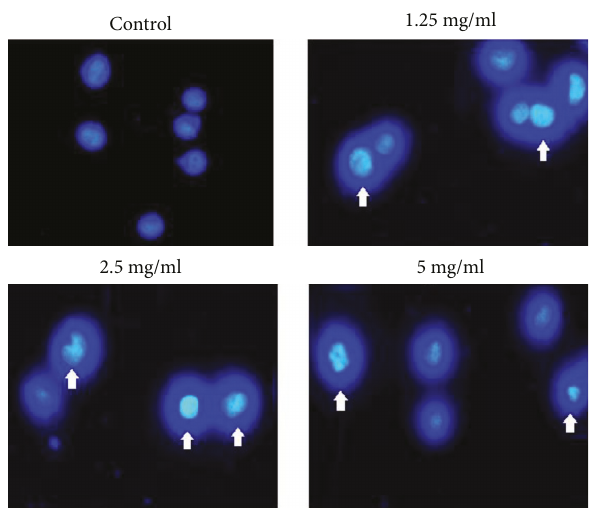
Figure 2: Effect of different concentrations of Cinnamon aqueous extract on 5637cell apoptosis by Hochest33258 staining. All × 40 magnification images are obtained by fluorescence microscopy.